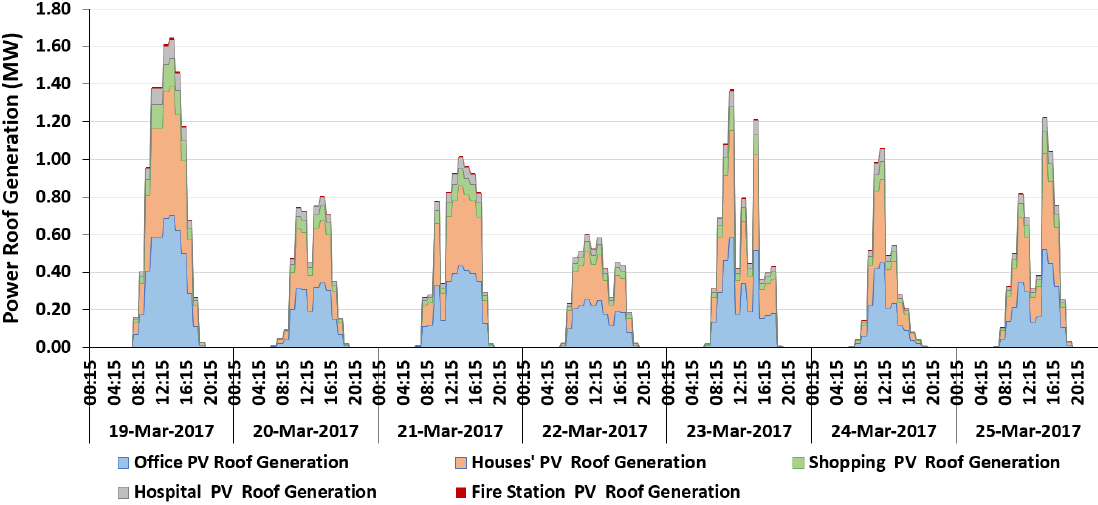
Figure 9. Roof PV generation from office, residential, hospital, fire station, and shopping mall buildings. The market price for the chosen week was obtained from the Iberian electricity market operator (OMIE) (www.datosdelmercado.omie.es/pt-pt/datos-mercado) and can be seen in Figure